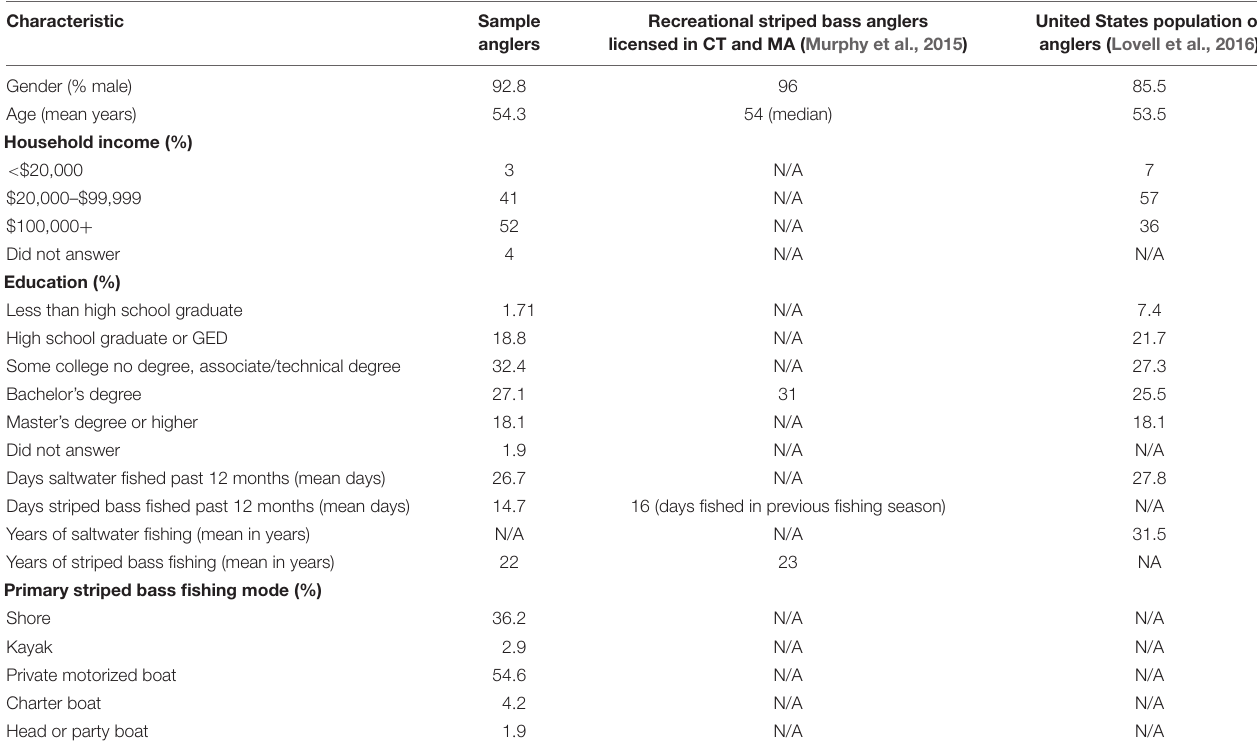
TABLE 3 | Characteristics of recreational striped bass anglers and the United States population of